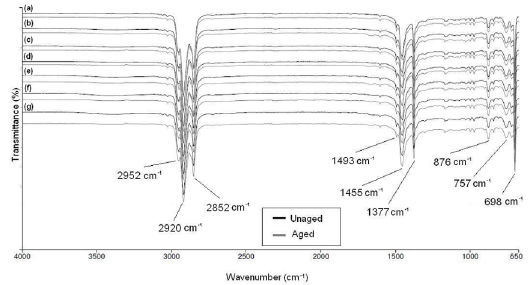
Figure 4. FTIR spectra of compounds (a) C-00, (b) C-ZnOPe-1, (c) C-ZnO-Pe3, (d) CZnOPe-5, (e) C-ZnOWR-1, (f) C-ZnOWR-3 and (g) C-ZnOWR-5.